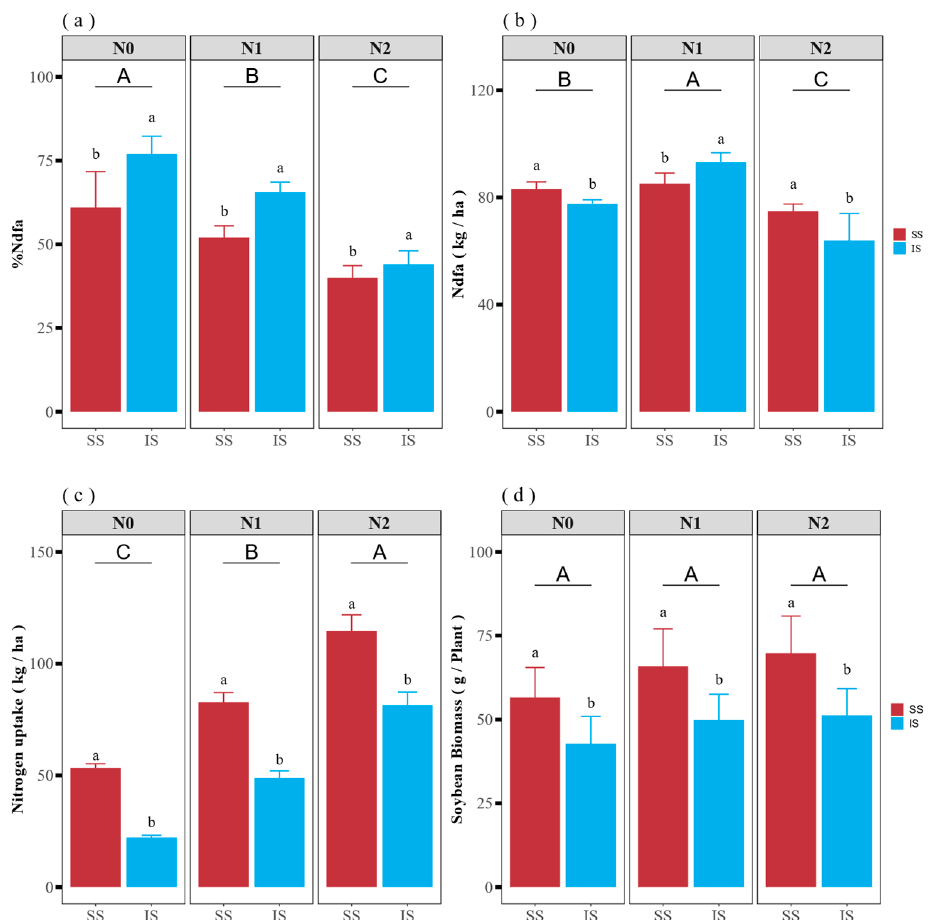
Figure 1. Nitrogen fixation efficiency ( a ) and biological nitrogen fixation ( b ) and nitrogen uptake in the soil ( c ) and biomass ( d ) of soybeans under different nitrogen application levels. Different lowercase letters indicate significant differences between single intercropping at the same nitrogen supply level ( p < 0.05), and different capital letters indicate significant differences between the same nitrogen supply level ( p < 0.05). Data are presented as a Mean ± SD ( n = 5).